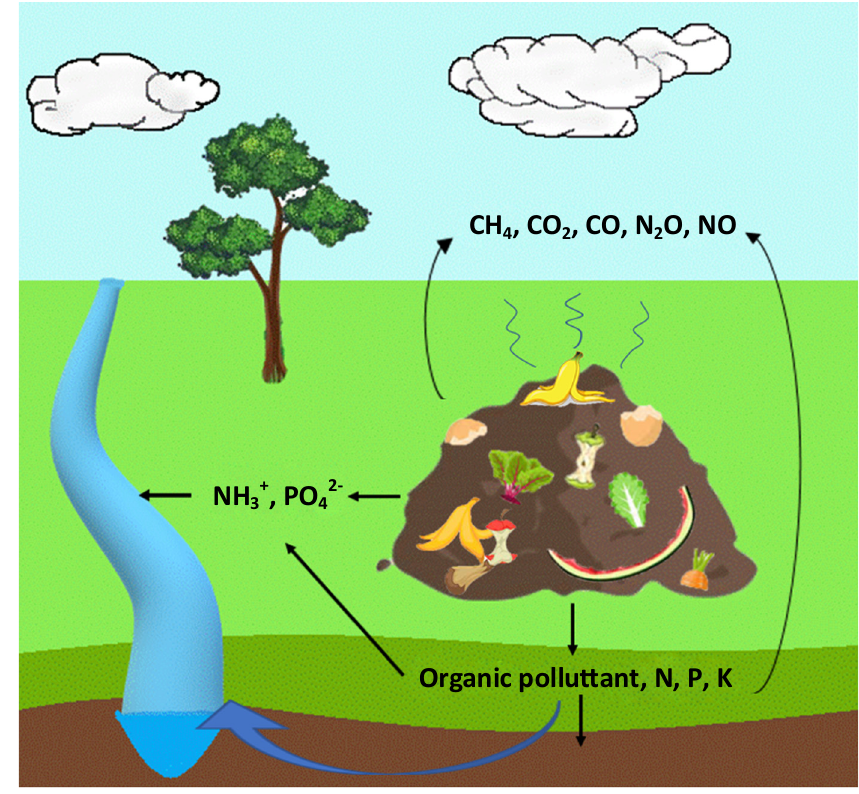
Figure 1: Impact of agricultural waste on the surrounding